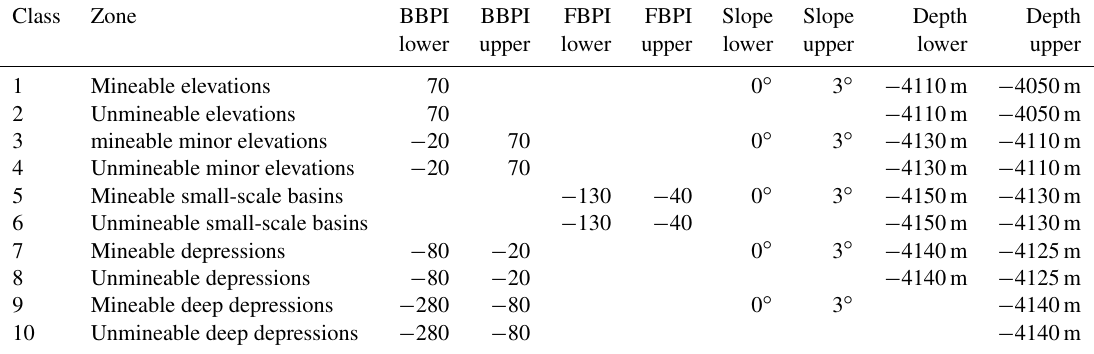
Table A3. Classification dictionary with upper and lower bounds for the classification of the working area used with the BTM.